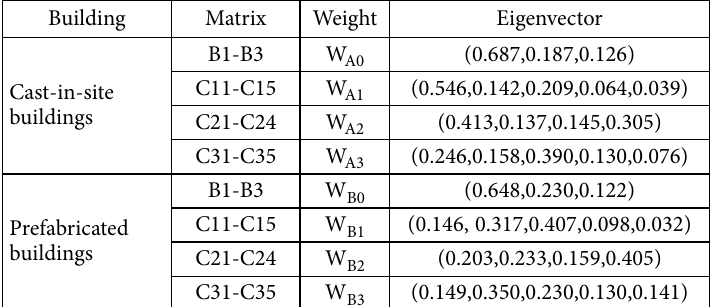
Figure A3.1. Index of the benefits Table A3.1 The weights of the